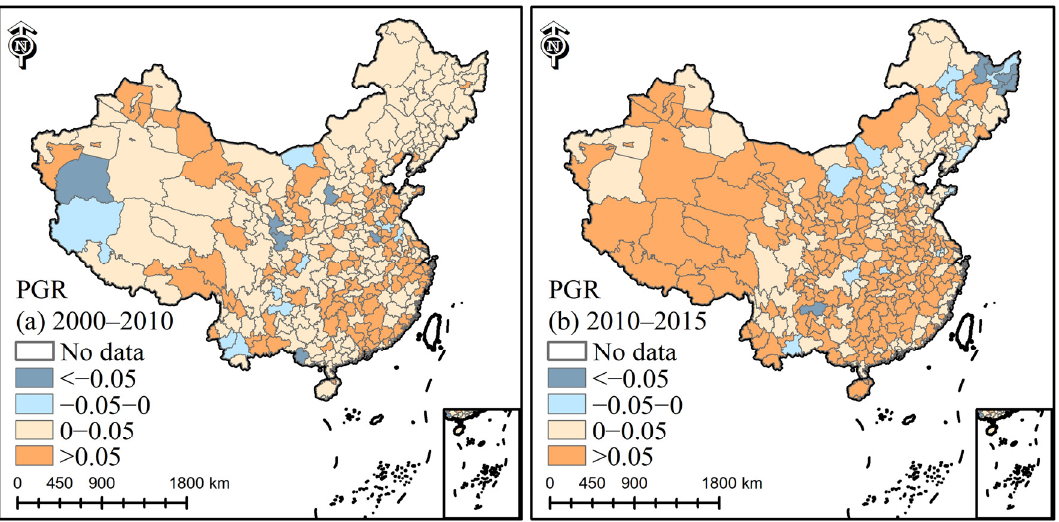
Figure 7. The spatial distribution of population growth rate (each polygon shape (city) is attached with a color, which represents the city’s PGR value).